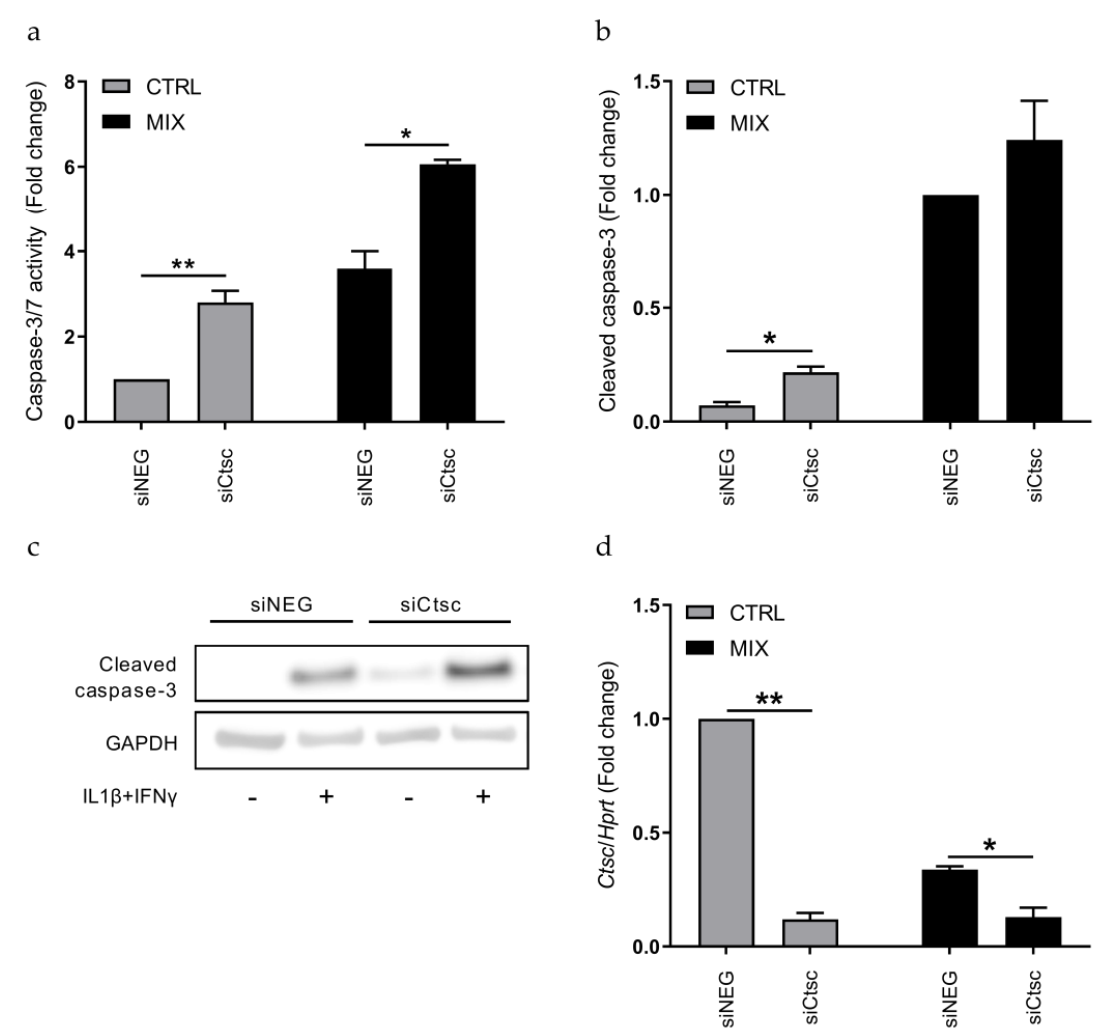
Figure 3. Knockdown of Ctsc increases caspase-3/7 activity in INS-1E cells. INS-1E cells were transfected with siRNAs against Ctsc (siCtsc) or a non-targeting negative control siRNA (siNEG) and then left untreated (CTRL) or exposed to IL-1 β and IFN- γ for 24 h (MIX). ( a ) Caspase-3/7 activity was normalized to total cell content, and data are presented as fold changes with means ± SEM ( n = 4). ( b ) Cleaved caspase-3 protein level as analyzed by immunoblotting. Gapdh was used as loading control. Data are presented as fold changes with means ± SEM ( n = 4). ( c ) Visualized protein bands of cleaved caspase-3 (~17–19 kDa) and Gapdh (~40 kDa), as presented in (b). The blot is representative of 4 blots. ( d ) Ctsc mRNA expression measured by real-time qPCR and normalized against Hprt . Data are presented as fold changes with means ± SEM ( n = 4). *: p < 0.05; **: p < 0.01.